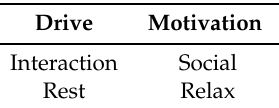
Table 1. Relationship between each drive and its